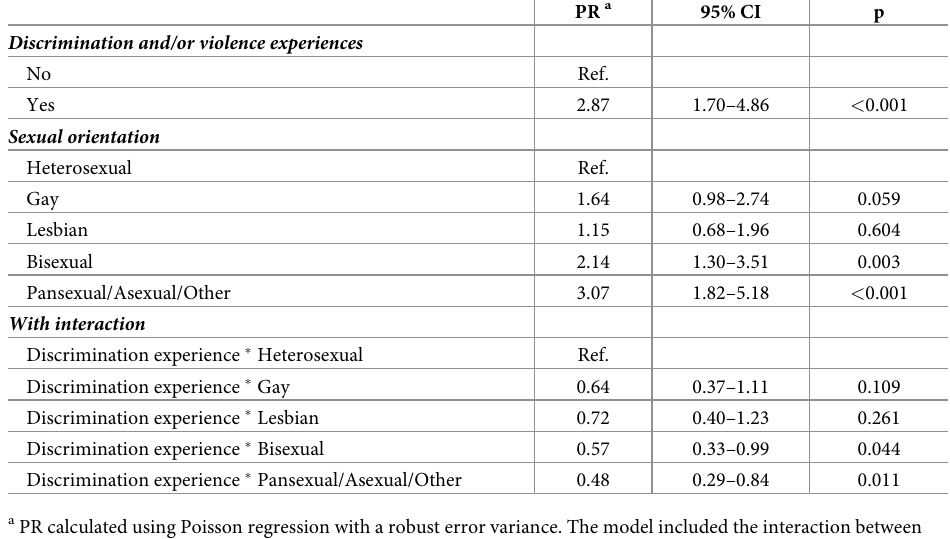
Table 4. Association between discrimination on mental health problems in the last 12 months adding the interac- tion of sexual orientation. Discrimination and/or violence experiences